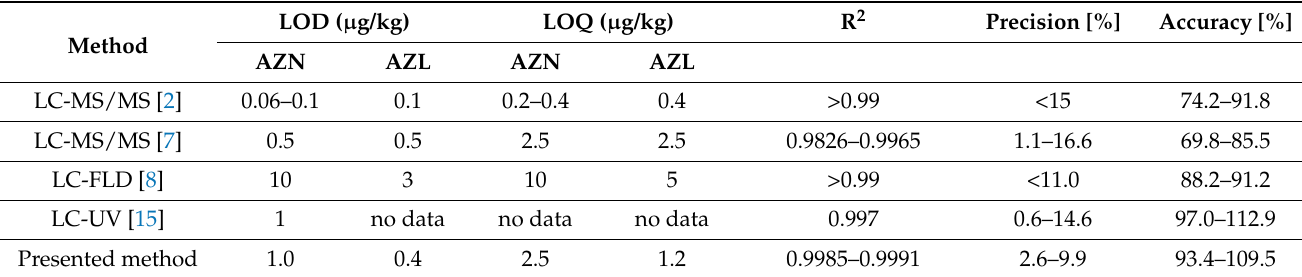
Table 2. Comparison the LOD, LOQ, R 2 , precision and accuracy values of the described method with published methods.